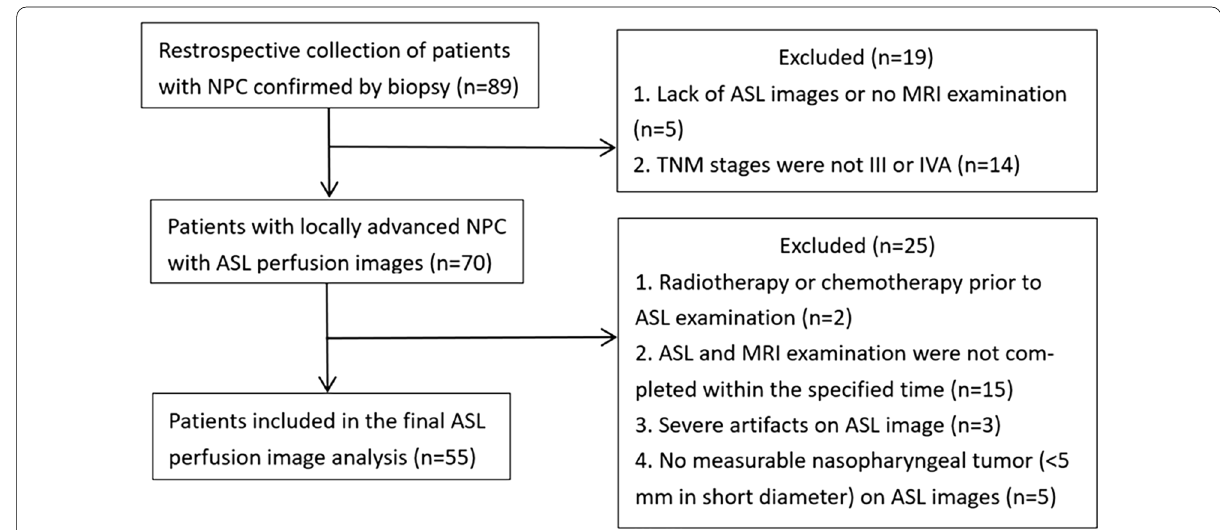
Fig. 1 Flow diagram of patient